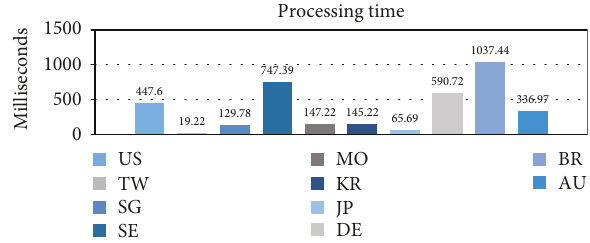
Figure 10: Geographical measurements of the emulation mode with hop (processing